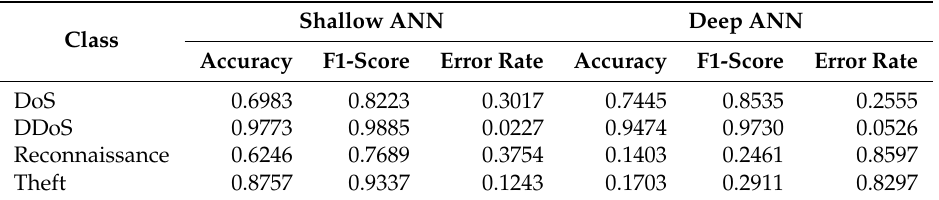
Table 7. Error rate for Type-A binary class models using the Bot-IoT dataset.